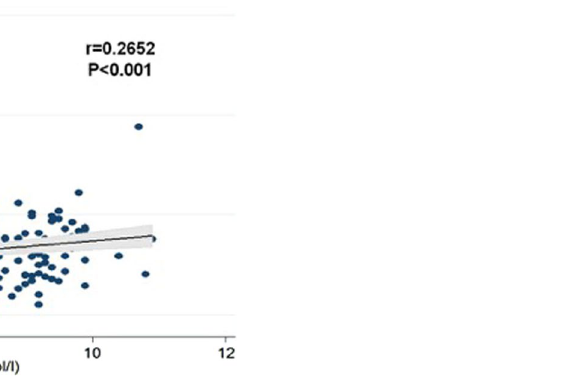
Figure 2. Correlation of left ventricular mass index and